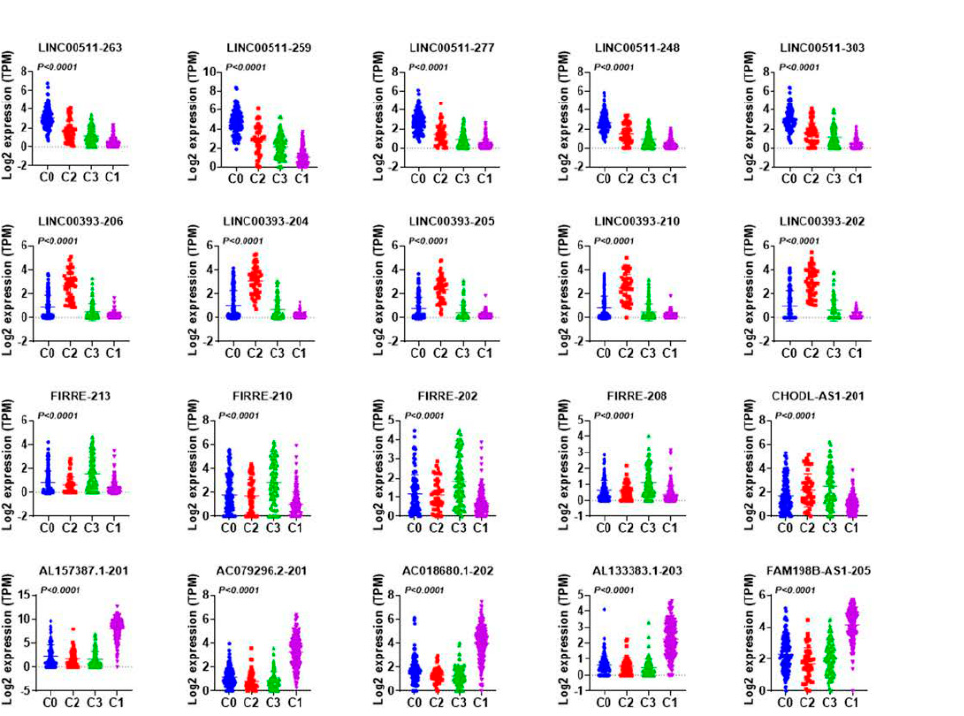
Figure 2. Molecular heterogeneity of TNBC employing lncRNA transcriptome. ( a ) Iterative clustering and guide-gene selection (ICGS) classification of TNBC and NT based on their lncRNA transcriptome, revealing four distinct clusters. ( b ) Uniform manifold approximation and projection (UMAP) dimensionality reduction analysis of TNBC and NT based on their lncRNA expression. ( c ) Scatter plot depicting the expression of the top 5 enriched lncRNA transcripts in each cluster (C0, C2, C3, and C1) in the same cohort.